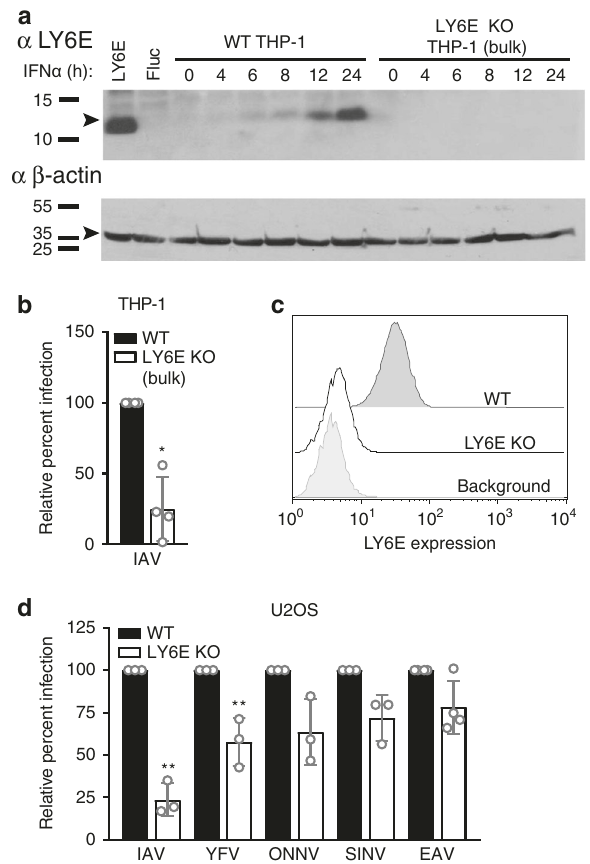
Fig. 3 Loss of LY6E reduces but does not abrogate viral infection. a WT THP-1 cells and a bulk population of THP-1 expressing a LY6E-speci fi c guide sequence and Cas9 (LY6E KO) were treated with 100 U/mL IFN α and harvested at indicated time points. LY6E and β -actin levels were assessed by Western blot. Lysates prepared from THP-1 ectopically expressing LY6E and fl uc control constructs were used as positive and negative controls. Data are from one of three independent experiments. b Bulk LY6E KO and WT THP-1 were infected with IAV (A/WSN/33, 0.025 MOI, 8 h, WT average 37.7% infection), then permeabilized and stained for NP. Percent infection was quanti fi ed by fl ow cytometry and is shown normalized to infection of WT THP-1. n = 4 biological replicates. c Cell surface levels of endogenous LY6E in LY6E KO and WT U2OS. Cells were stained with anti- LY6E antibody and analyzed by fl ow cytometry. Background levels were determined by staining with an isotype control. d LY6E KO and WT U2OS were infected with IAV (A/WSN/33, 0.32 MOI, 8 h, WT average 27.9% infection), YFV-17D-Venus (0.6 MOI, 24 h, WT average 50% infection), ONNV-GFP (0.5 MOI, 17 h, control WT 18.9% infection), SINV-GFP (0.2 MOI, 10 h, control WT 14.6% infection), and EAV-GFP (0.8 MOI, 19 h, average 4.2% infection). Percent infection was quanti fi ed by fl ow cytometry and is shown normalized to infection of WT. n = 4 biological replicates for EAV and n = 3 biological replicates for IAV, YFV, ONNV, and SINV. * p < 0.05, ** p < 0.01. SD is shown. Data were analyzed prior to normalization by using student ’ s unpaired t- test with Welch ’ s